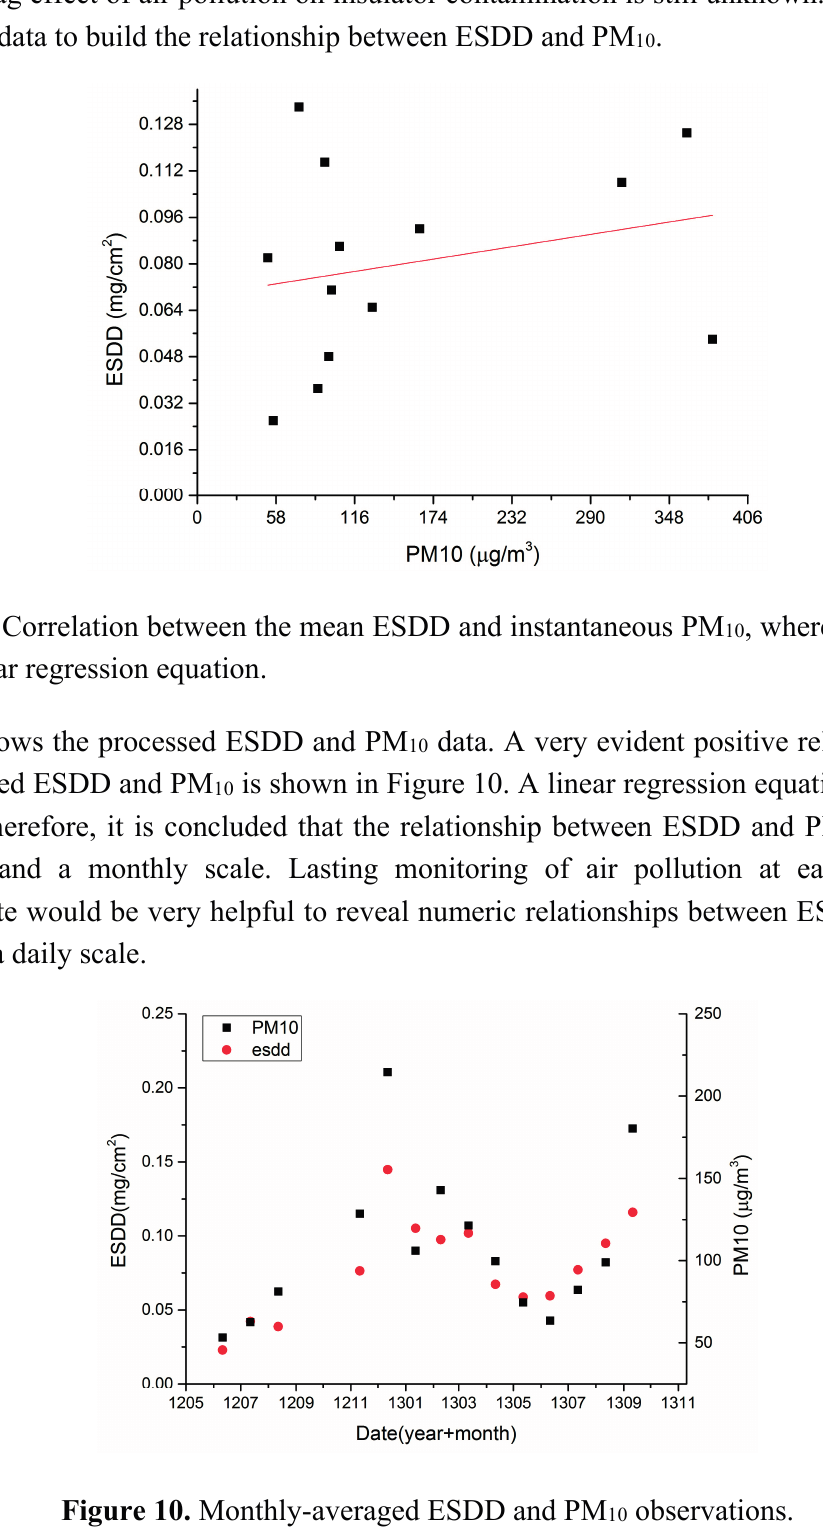
Figure 10. Monthly-averaged ESDD and PM 10